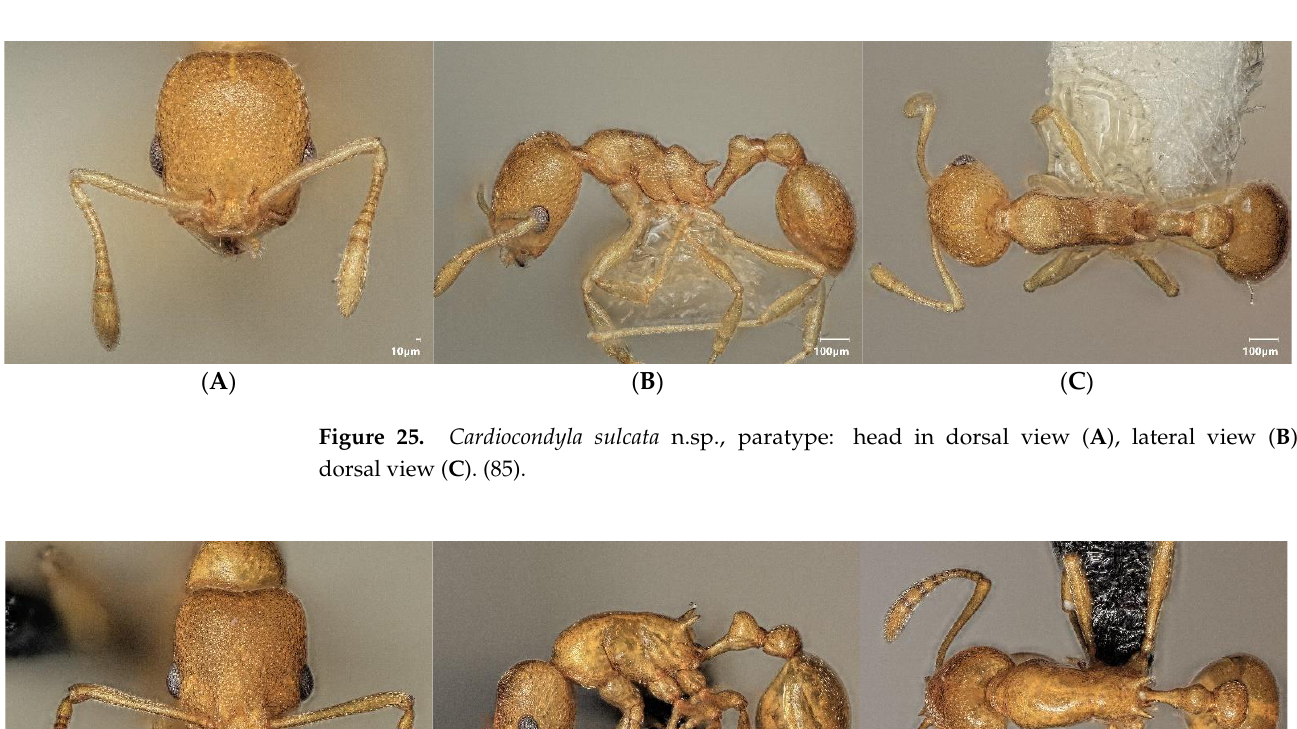
Figure 26. Cardiocondyla sima : head in dorsal view ( A ), lateral view ( B ), dorsal view ( C ).